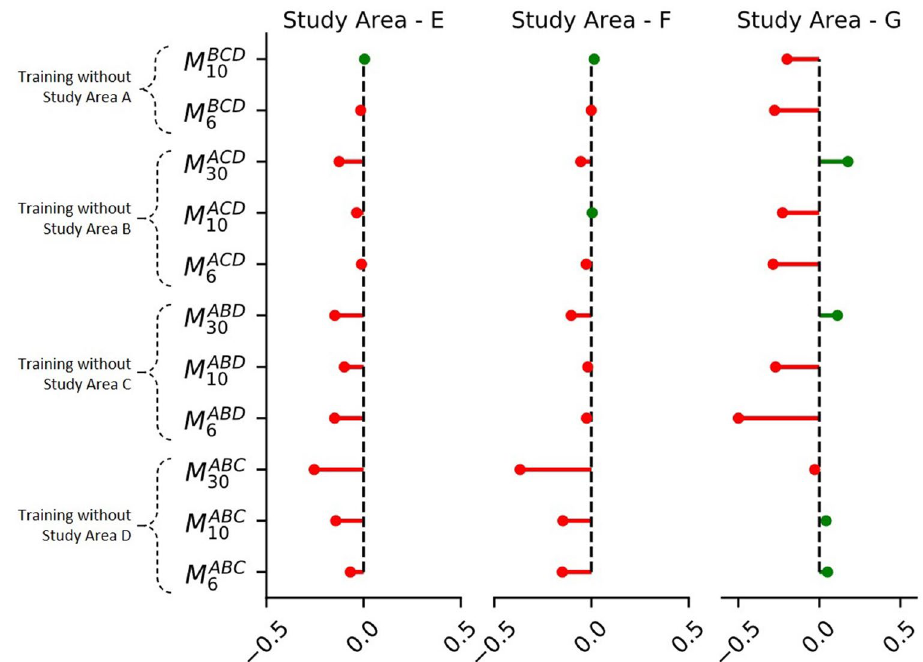
Figure 6. Jackknife’s approach for training new CNNs on combined landslide inventories. Here, we rule out the possibility of a bad inventory bringing down the performance of the combined learning approach. The values in X-axis are the difference of MCC score of the new model with the MCC score of M decrease in MCC score, and a green line shows an increase in MCC score. An example of nomenclature used ABC here: the symbol M